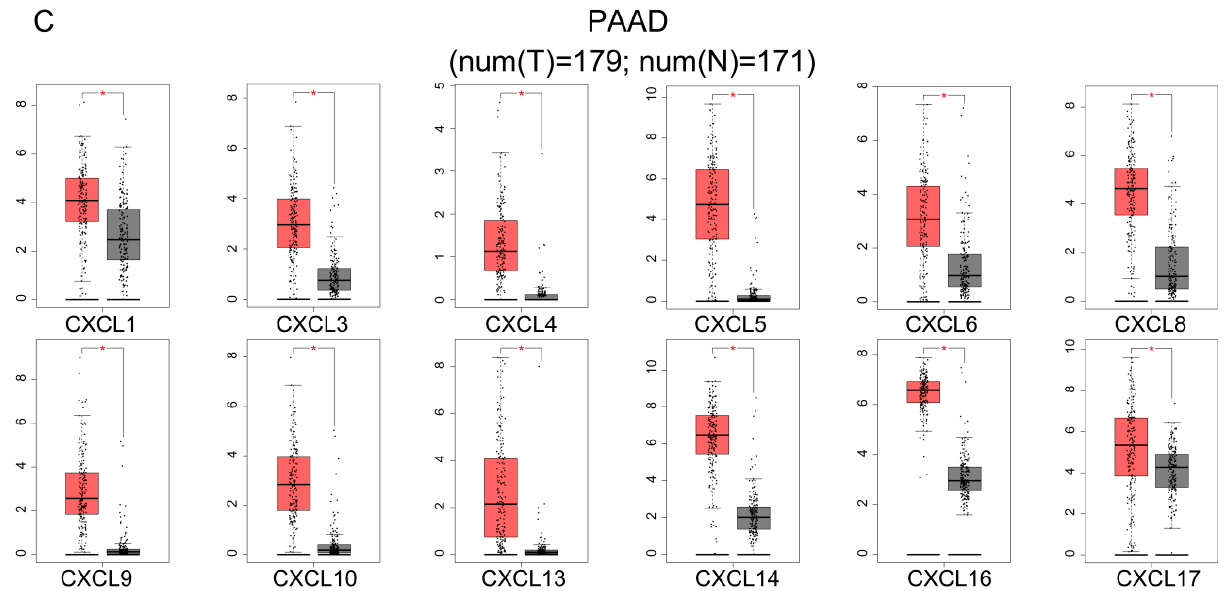
Figure 4. GEPIA analysis of the mRNA expression levels of CXCs in BRCA, COAD, and PDAC. Box plots of individual CXC expression in BRCA ( A ), COAD ( B ), and PDAC ( C ) tissue and normal tissues; p value ≤ 0.05.